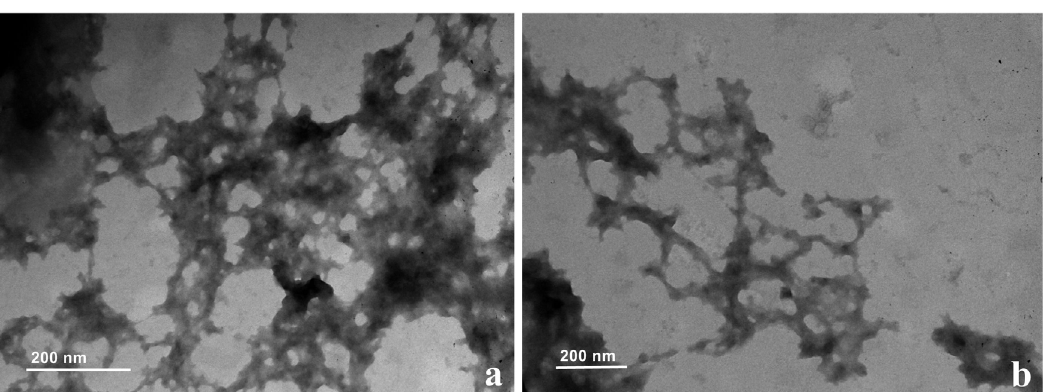
FIGURE 2 - TEM images of chitosan/pGM-CSF complexes (10/1). a. 75.000× magnification, b.100.000×